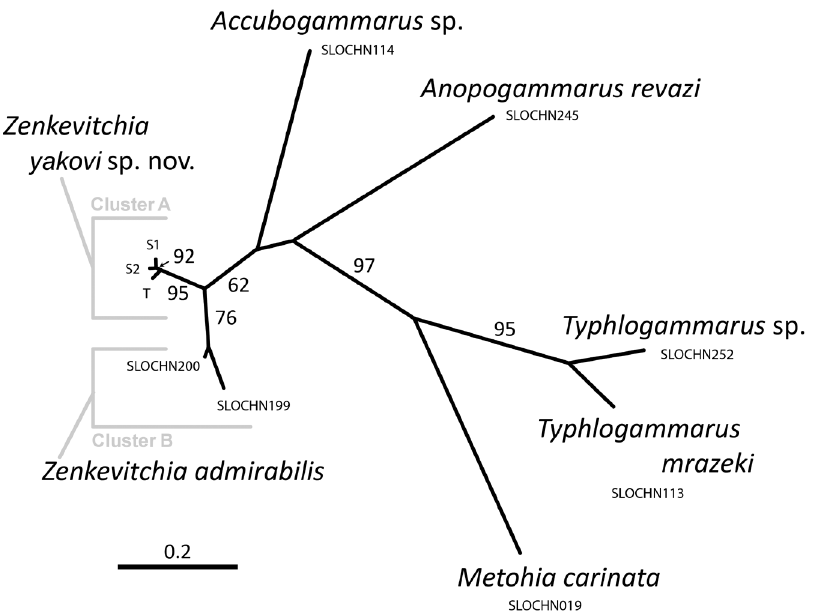
Figure 1. Unrooted maximum-likelihood cladogram with bootstrap probabilities based on the mito- chondrial cytochrome c oxidase I (COI) sequences for representatives of species within the family Ty- phlogammaridae. Specimen labels refer to information given in Table 2. Scale bar indicates the number of substitutions per based on the uncorrected pairwise distances (Table 3). The monophyly of Zenkevitchia within the Typhlogammaridae is supported by moderate bootstrap values (62%) and the haplotypes for the two Zenkevitchia species differ from the rest of the Typhlogammaridae by the uncorrected pairwise distances mean sequence divergences of 45.4%.